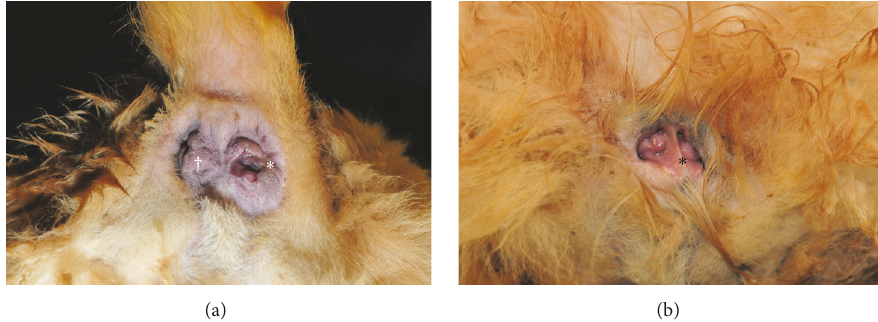
Figure 1: (a) and (b) Two functional anal openings. This photograph depicts the locations of the two anal openings, left ( † ) and right ( ∗ ). Both openings were situated off-center from midline by a few millimeters. The left anal opening is positioned more off-center, anatomically narrower, and angled more laterally than the larger right anal opening. (b) Vulva and vestibule. This photograph depicts the complete septum ( ∗ ) and the small clitoris with smaller than usual openings into each vaginal canal. Dorsal is toward the bottom of the